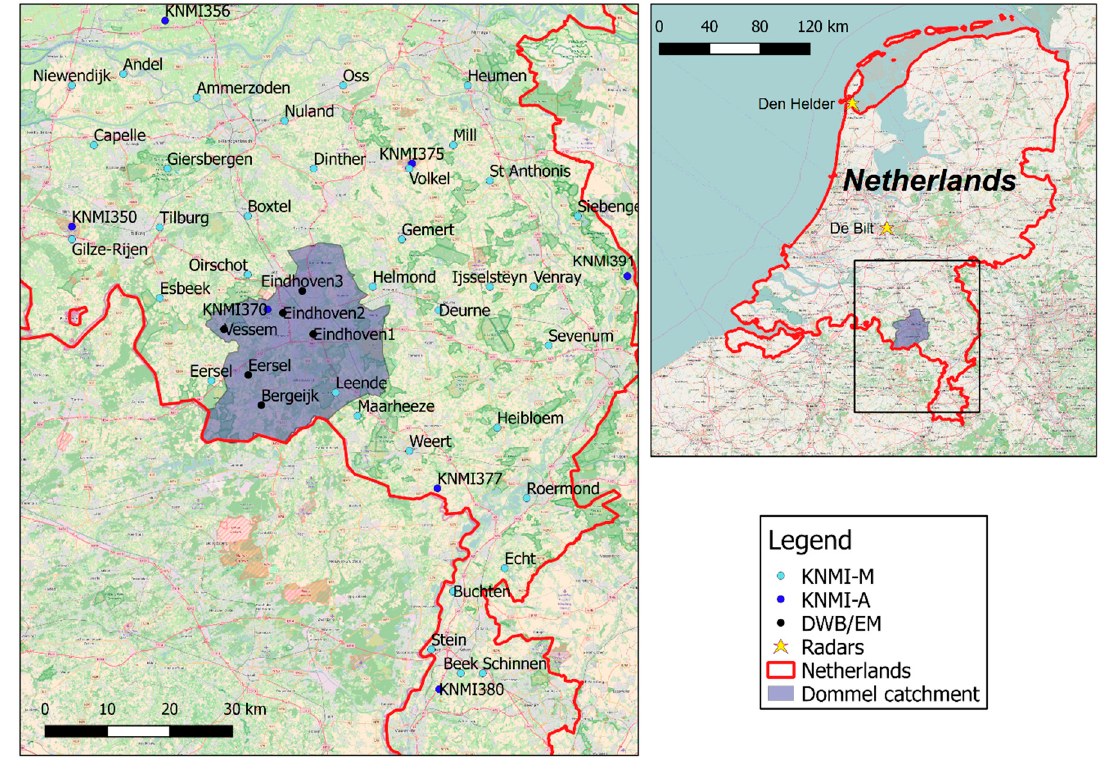
Figure 1. The Figure shows the position of the rain gauges and of the Dommel catchment inside the study area on the left; the position of the radars and of the study area (black rectangle) relatively to the Netherlands on the right.